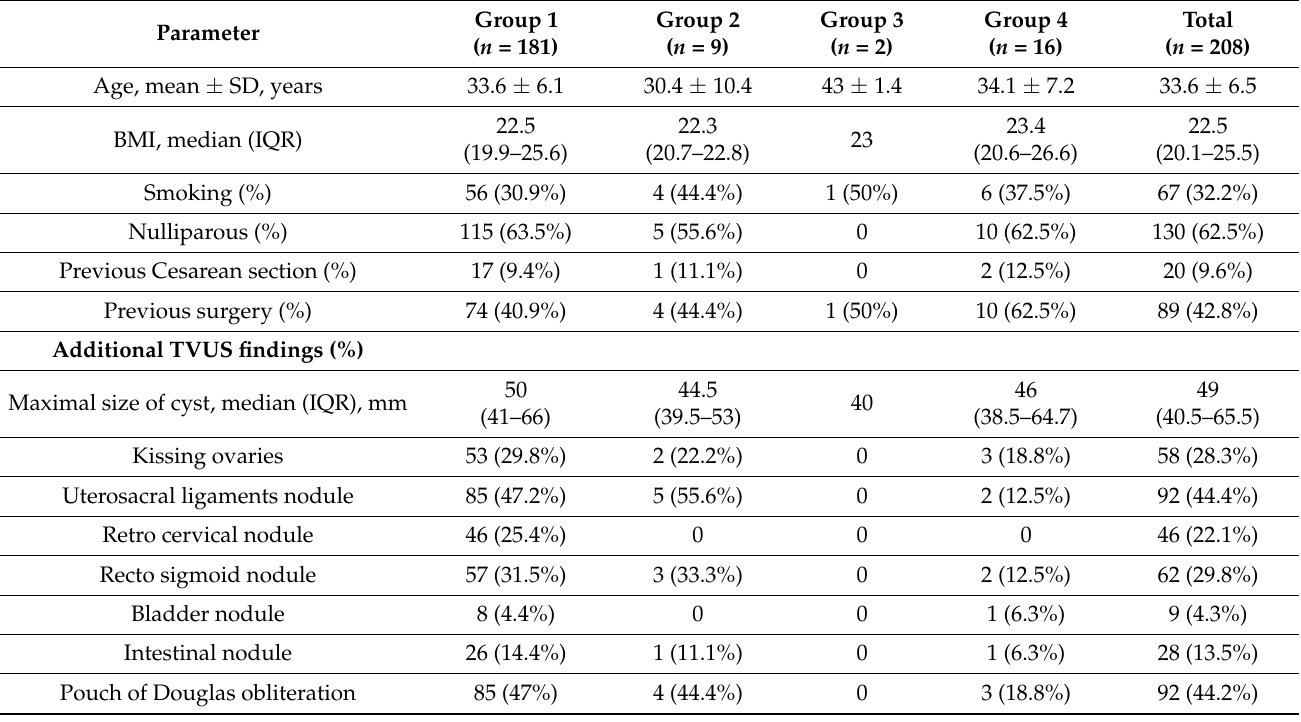
Table 1. Demographic, clinical data and prevalence of TVUS findings of patients attending an endometriosis tertiary referral center and included in the study ( n =